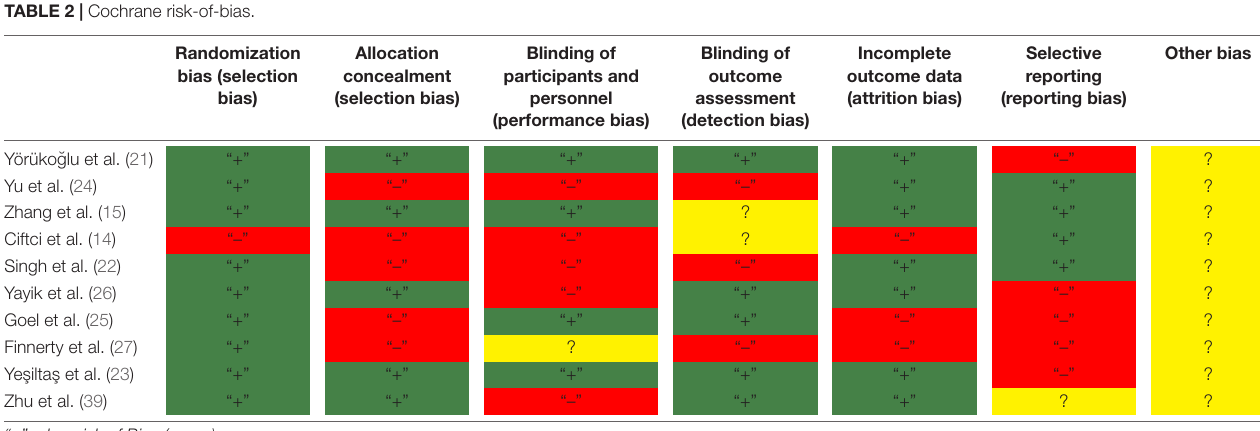
TABLE 2 | Cochrane